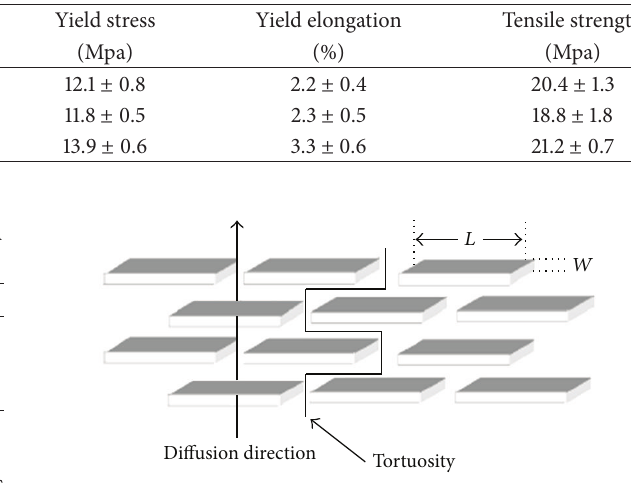
Figure 6: Regular arrangement of orthogonally shaped platelets in a parallel array with their main direction perpendicular to the diffusion direction (reproduced from